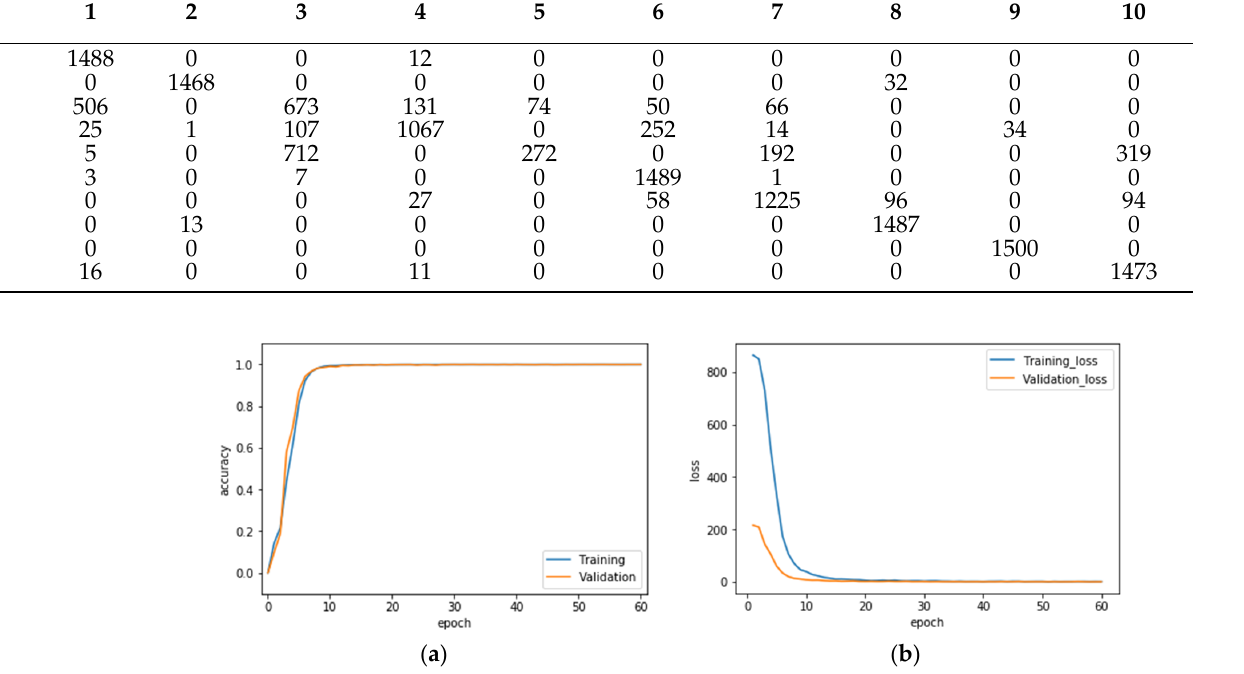
( b ) Figure 21. Recognition rate (a) and loss value (b) curves of the VGG-16 CNN model training using mean-mean wavelet fused images. Table 8. Training and test time of the hand gesture intention recognition of the proposed VGG-16 CNN deep learning with wavelet image fusion of CCD RGB-IR and depth-grayscale using “max-min”, “min-max” or “mean-mean” merge types on the hand gesture database (10 classes of gesture intention actions with 25 actions collected in each class contained in each of the training and test databases). Merge Types of Wavelet Image Fusion for VGG-16 CNN